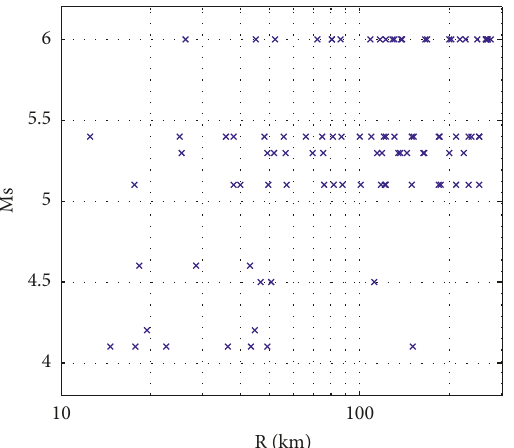
Figure 2: Magnitude of Ms versus distance for all recordings from nine